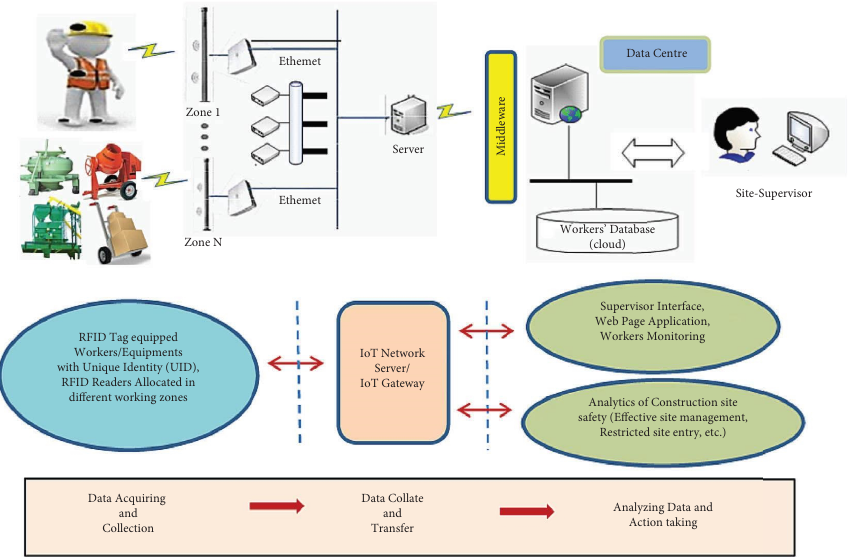
Figure 1: IoT-enabled UHF-RFID system architecture.